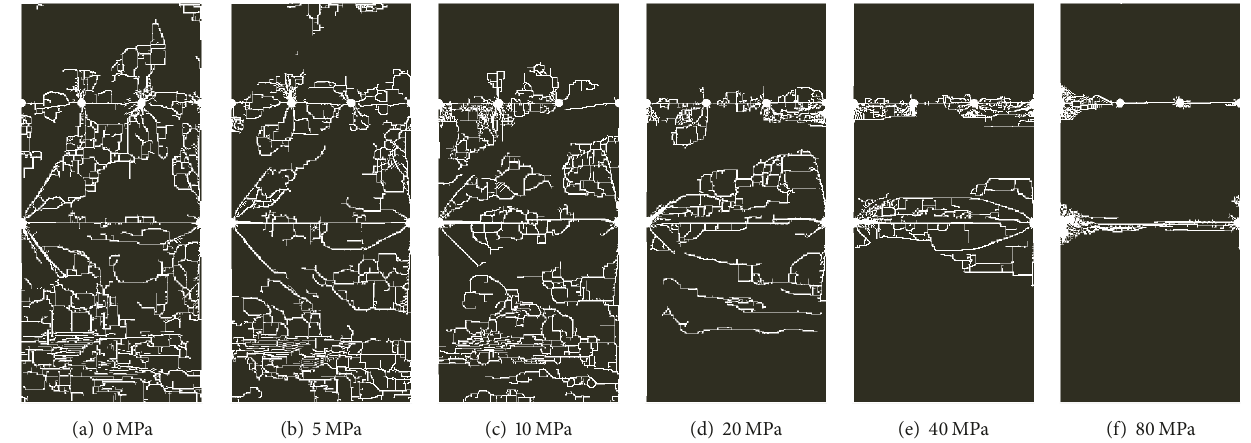
Figure 14: The crack forming diagram of rock mass under different crustal